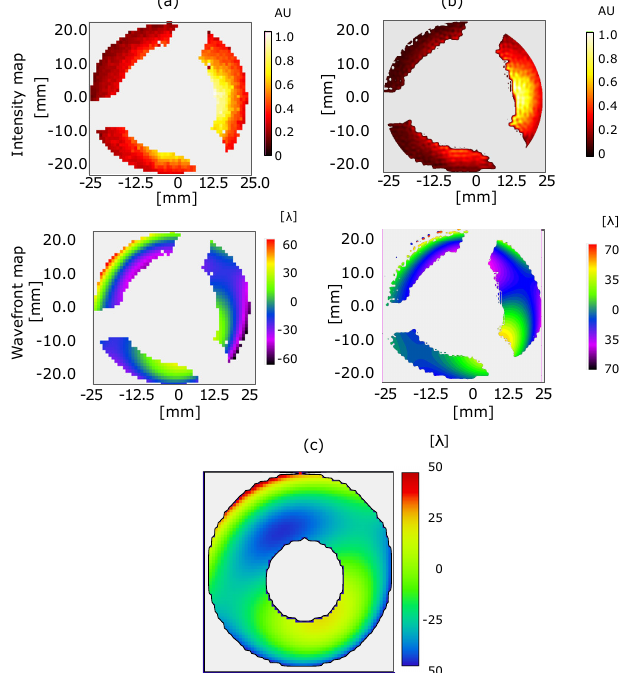
Figure 9. Intensity and wavefront map of Schwarzschild pattern obtained with ( a ) centroid and ( b ) Fourier Demodulation reconstruction methods. ( c ) Zemax simulation of the wavefront map.